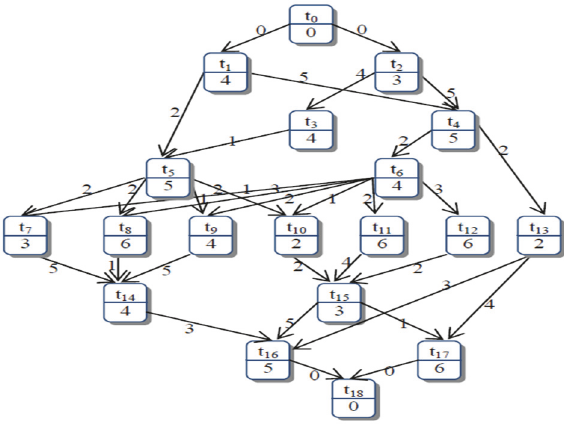
Figure 6: A sample task graph (from [8]).